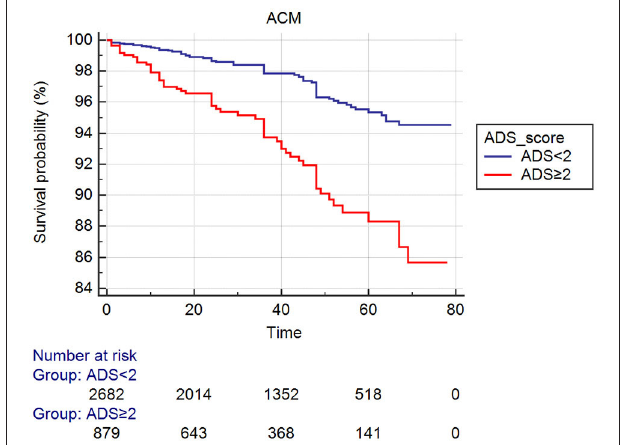
FIGURE 3 | Cumulative Kaplan–Meier estimates of the time to the first adjudicated occurrence of primary endpoints (CM).